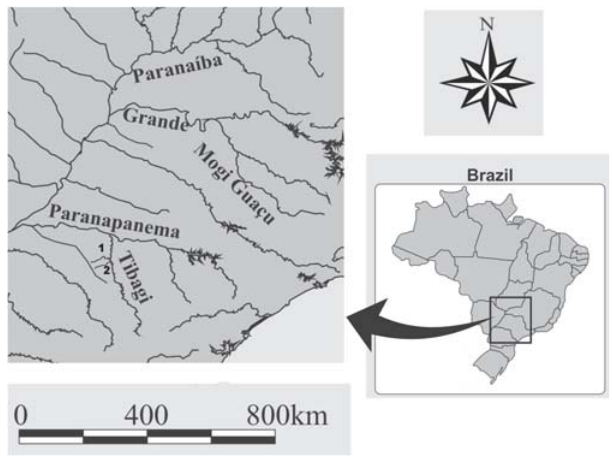
Fig.1 . Hydrographic map showing rio Mogi-Guaçu, rio Tibagi, 1 = ribeirão Três Bocas and 2 = ribeirão dos Apertados (tribu- taries of the rio